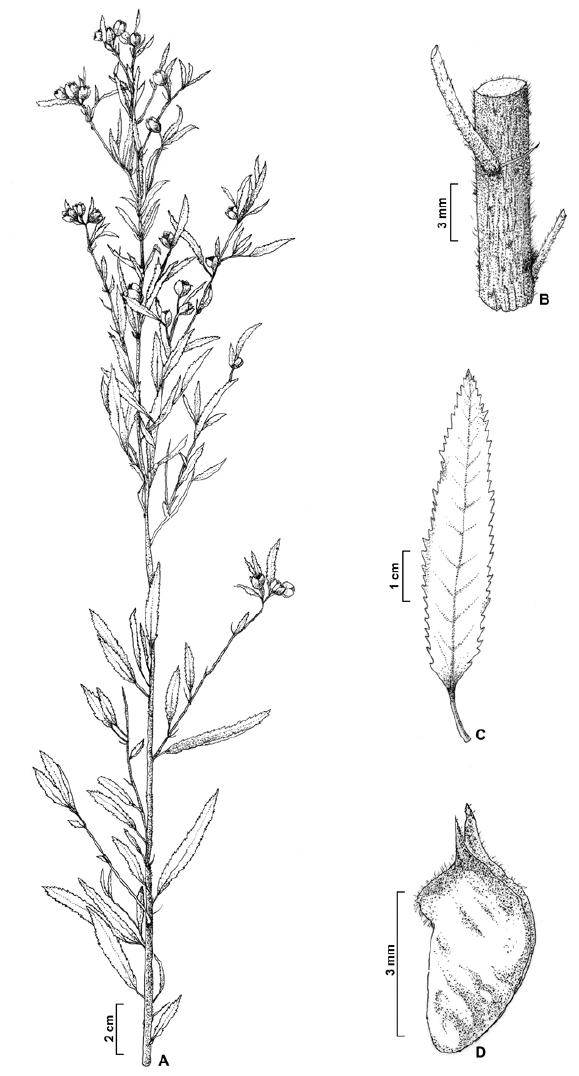
Figure 1. Sida elliottii var. elliottii . A. Branch with flowers and